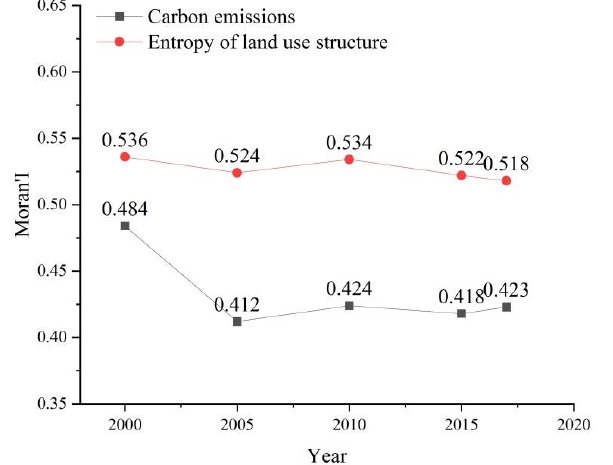
Figure 9. Moran’s I of carbon emissions and information entropy of land use structure: 2000 − 2018.